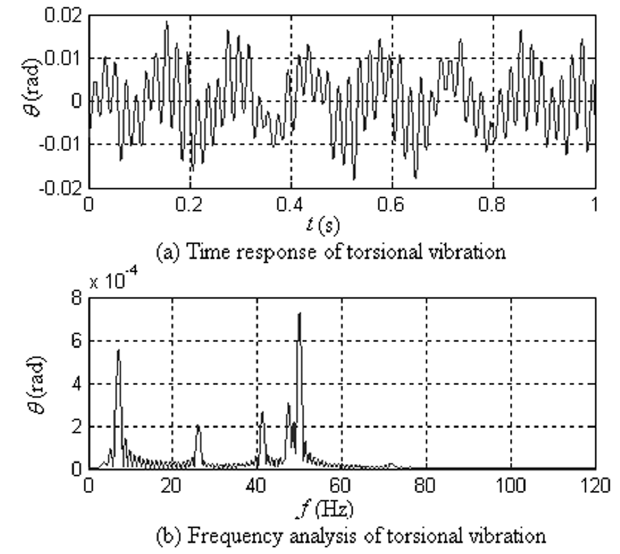
Fig. 9. Response and frequency analysis of the torsional vibration under 120 ◦ asynchronous juxtaposition.